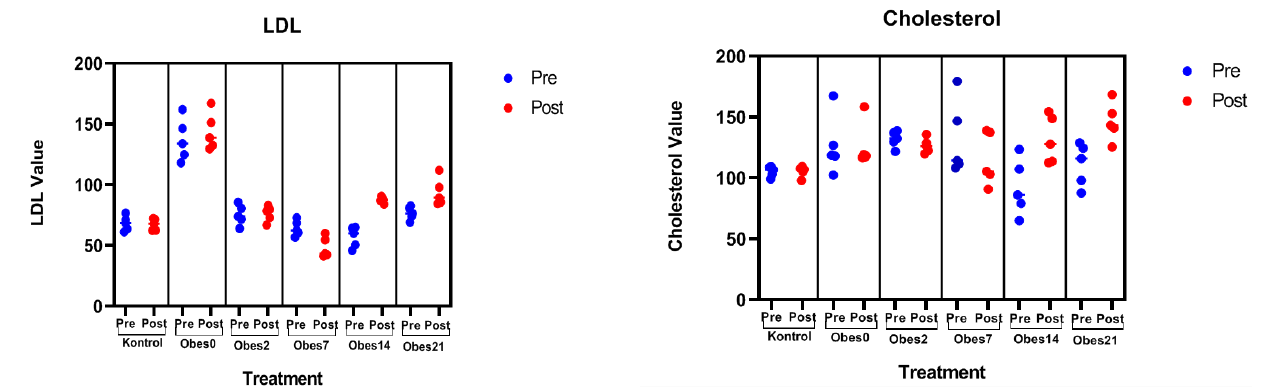
Figure 2. Results of cholesterol and LDL levels before and after exposure in each group. p < 0.05, there is a significant difference.